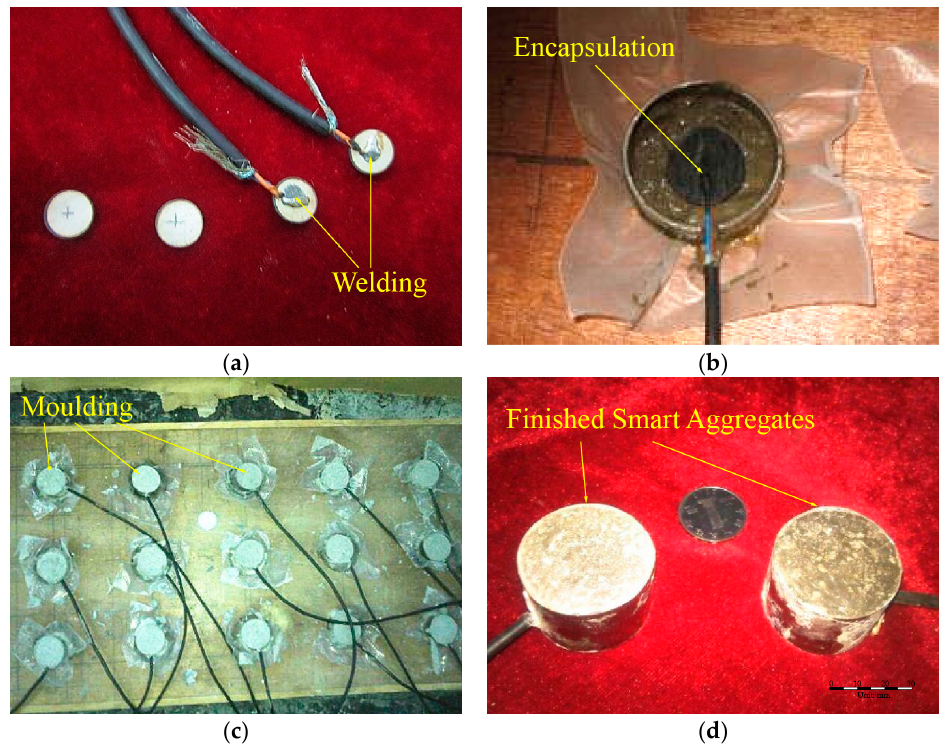
Figure 5. Production process of smart aggregates. ( a ) Welding; ( b ) Encapsulation; ( c ) Moulding; ( d ) Finished smart aggregates.